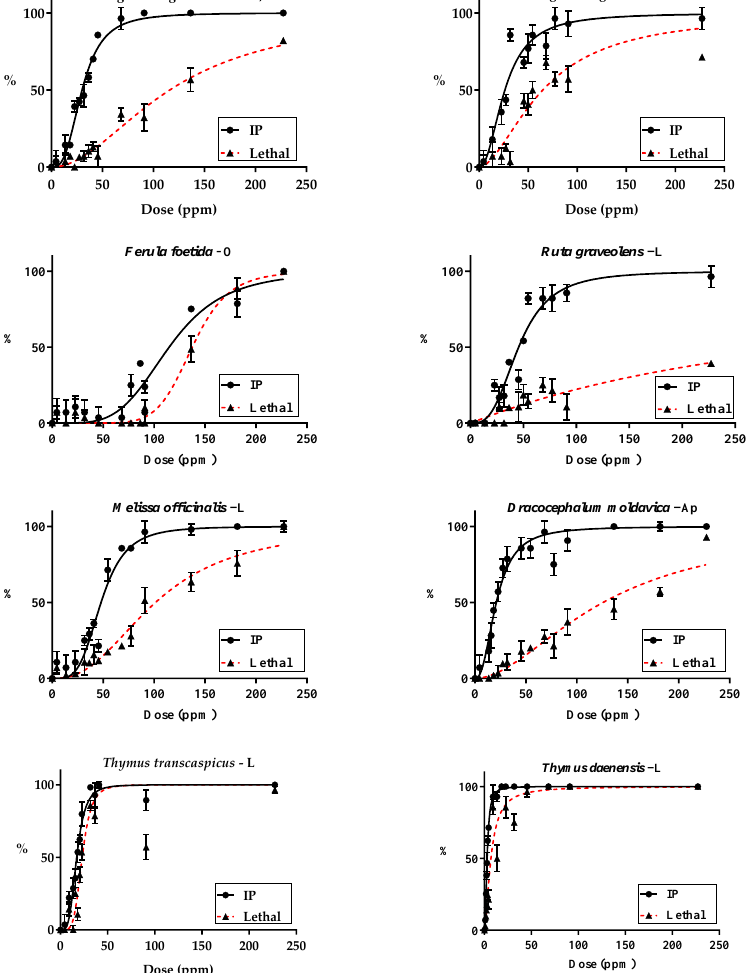
Figure 4. Dose–response diagrams of germination inhibition and embryo lethality of lettuce a ff ected by 16 EOs in cotton swab method. IP: Inhibition Percentage, Lethal: Lethal percentage.